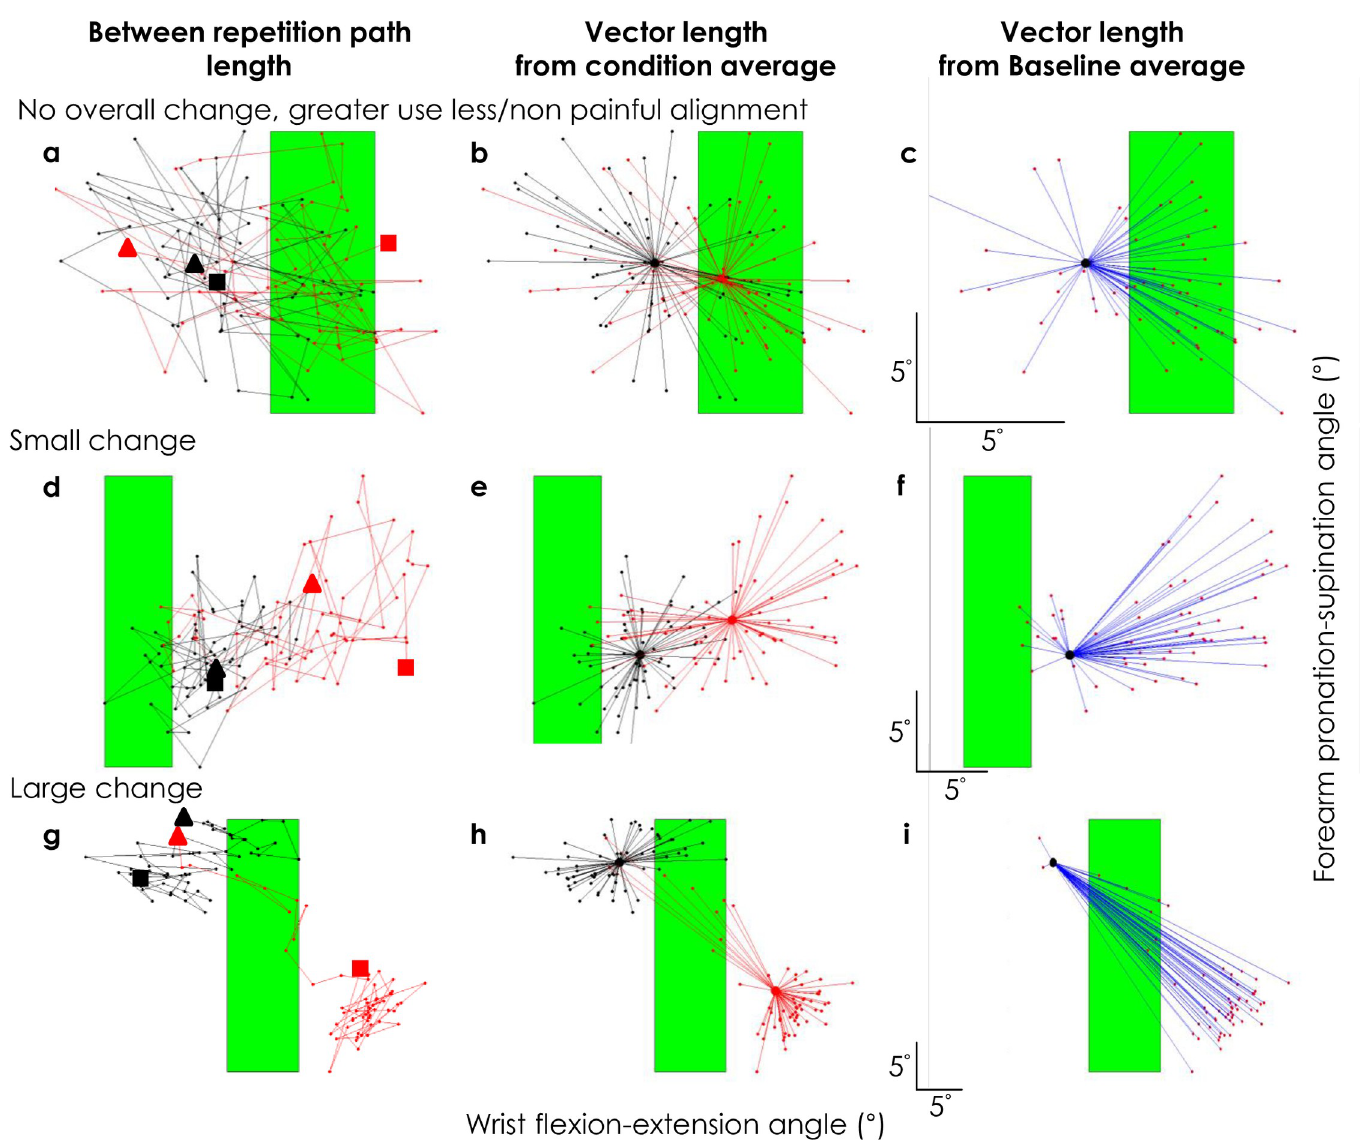
5–0 groups who used ‘no overall change, greater use of less noxious stimulation’ (a-c), ‘small change’ (d-f), or ‘large change’ (g-i). In all plots black and red circles/lines depict the Baseline and Experimental blocks, respectively. Plots show forearm pronation-supination angle vs. flexion-extension angle for the 60 repetitions of each block. Separate sub-plots represent different analyses. In the left panels, lines show path length plotted between consecutive repetitions of each block starting with repetition 1 (large triangles) and ending with repetition 60 (large squares). Middle panels show the alignment of the wrist/forearm in the secondary planes for the 60 repetitions relative to the mean alignment (large circles) for each block. Right panels show ‘vector length’ (blue lines) of wrist/forearm alignment in the pain condition relative to the mean alignment of the Baseline block. Note that different scales are used for the axes of the three movement strategies. Scale bars in the bottom left corner of each sub-plot in the right panels represents 5˚ in each direction (i.e. pronation-supination, flexion-extension). Green shaded areas represent the range of alignments in the flexion-extension direction selected for the less intense noxious stimulus. The three plots for each participant are presented with the same